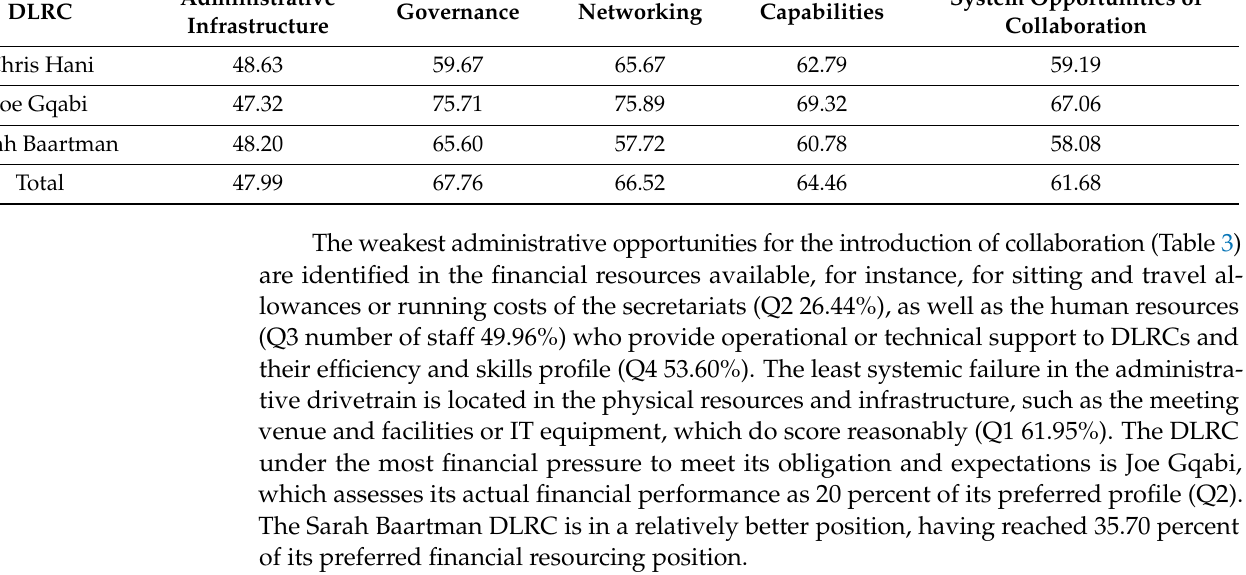
Table 2. (Sub) systems and opportunities of collaboration in DLRCs (average standardized assessment score in %). DLRC